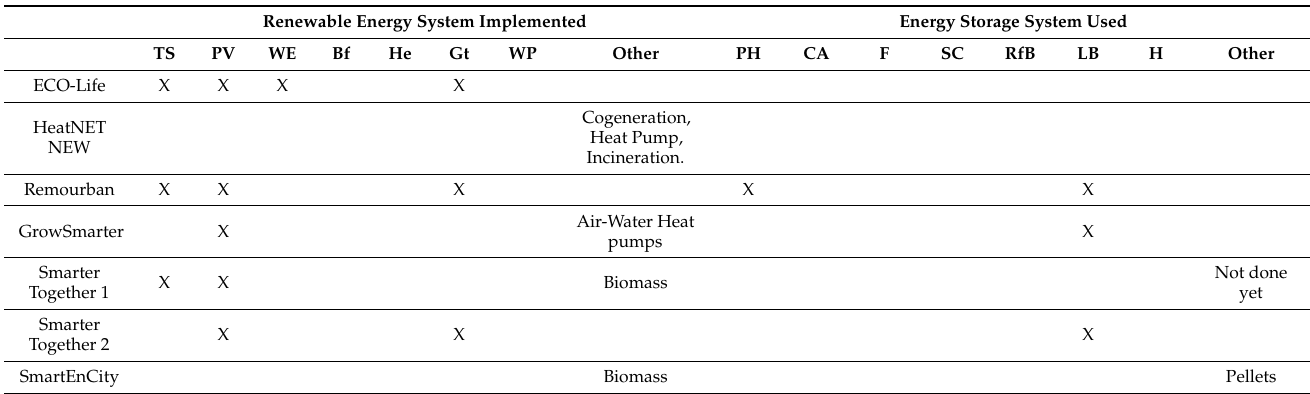
Table 6. Renewable energy systems and energy storage systems used in the projects participating in the survey. Renewable Energy System Implemented